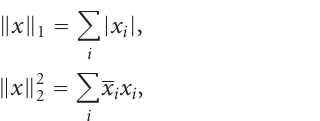
Algorithm 1 briefly outlines the procedure for